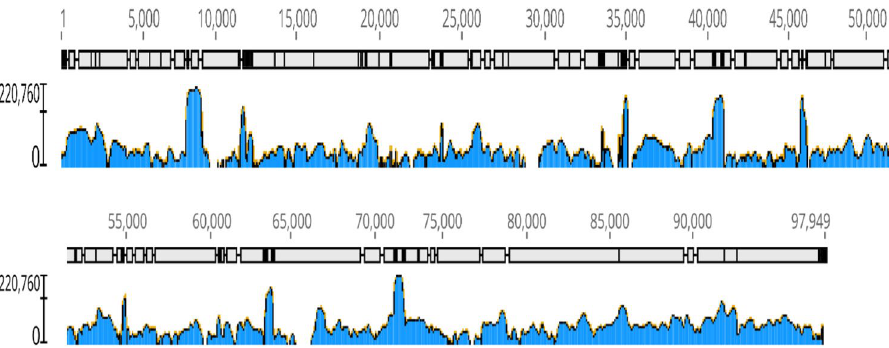
Figure 1. Genome coverage of the feline feces crAssphage genome (MW063138).